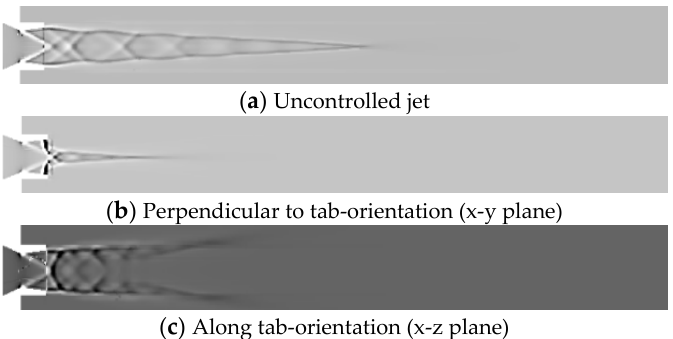
Figure 30. Schlieren views of uncontrolled and controlled jets at NPR 5 (underexpansion).